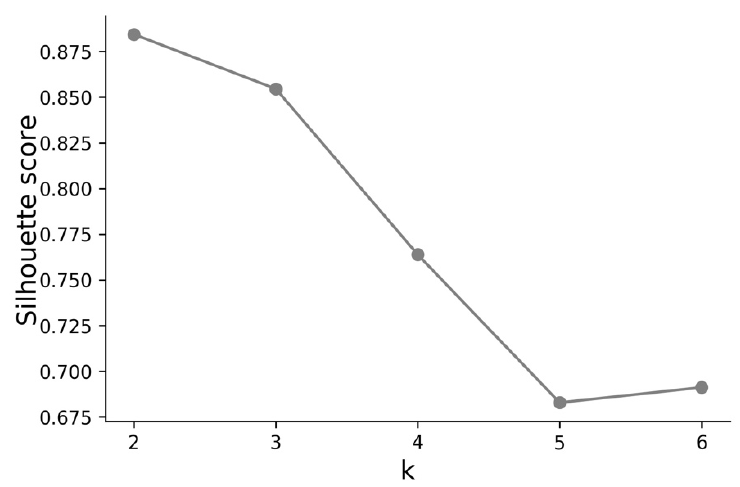
Figure 2. Silhouette score for countries temporal clustering of COVID-19 cases by 100,000 of the population (k = number of clusters).